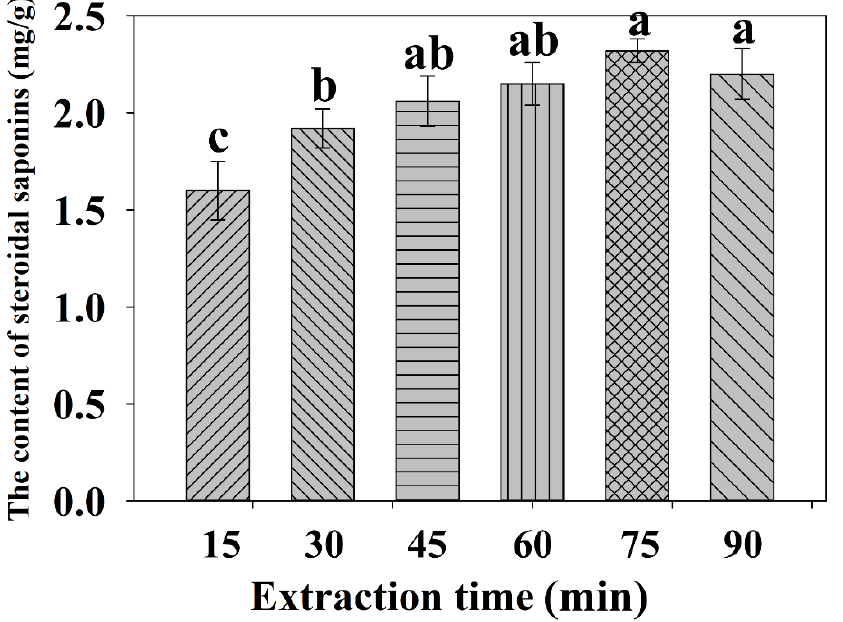
Figure 4. Effect of extraction time on the yield of total steroidal saponins. Different lowercase letters represent the difference among treatments of extraction time, p ≤ 0.05. Error bars indicate mean values ± SD, ( n = 3).